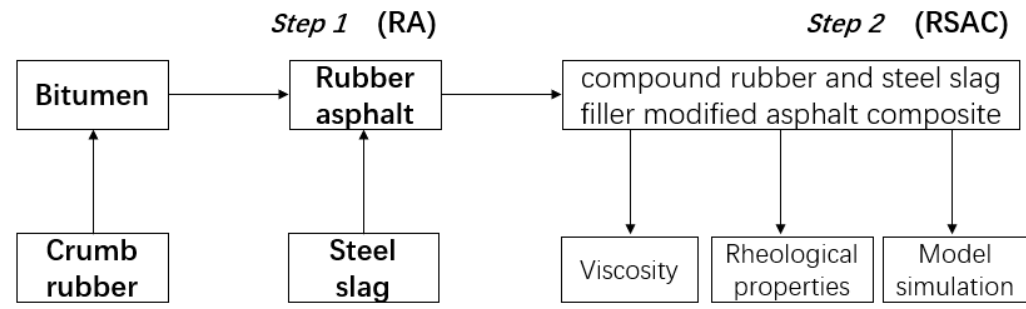
Figure 1. The flowchart for this study.